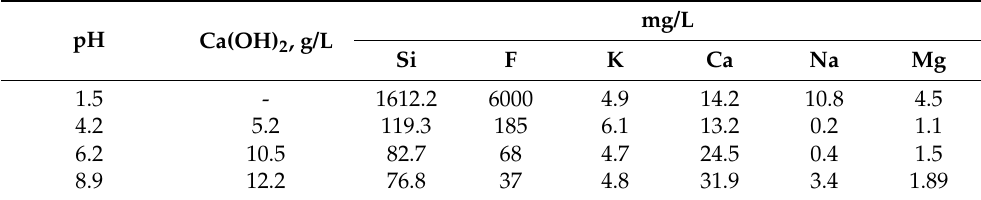
Table 3. Quantitative analysis of the liquid phase of sludge after treatment with lime at different pH values.